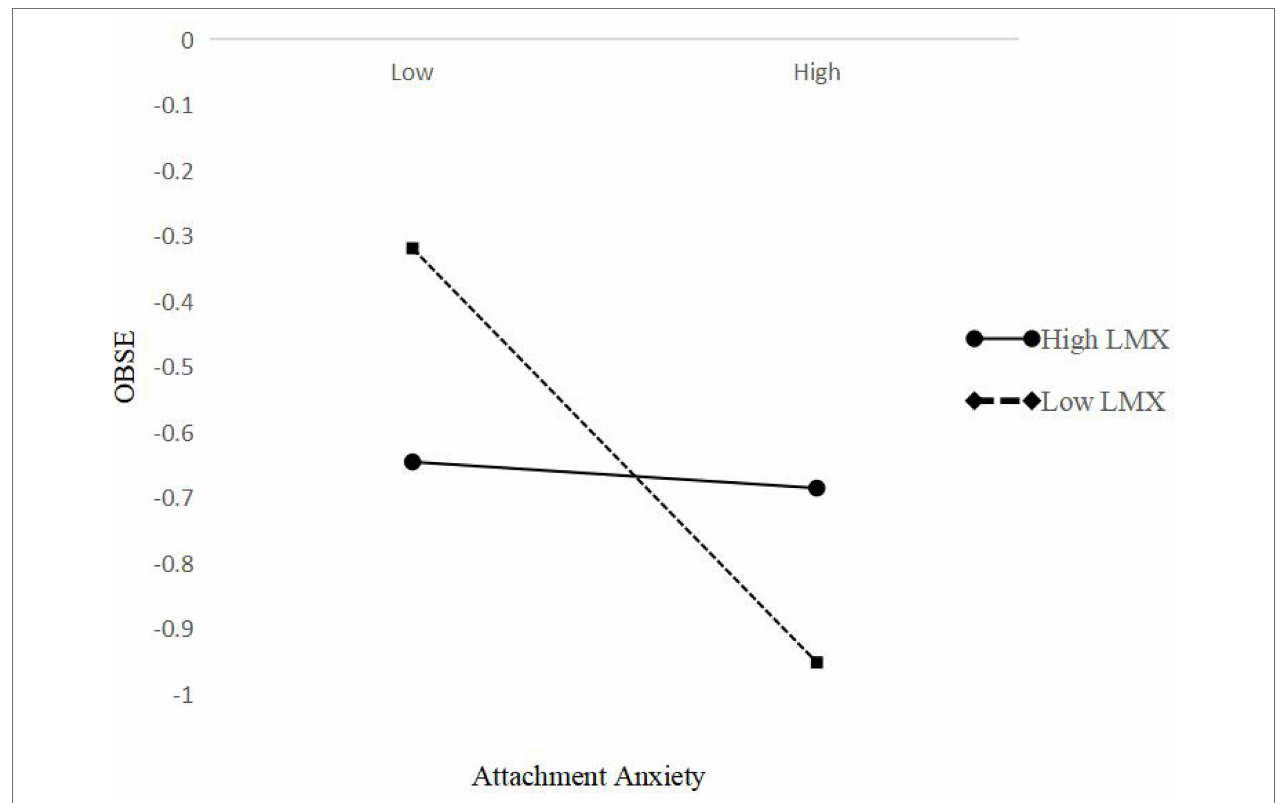
FIGURE 3 | Interactive effects of attachment anxiety and leader–member exchange (LMX) on organization-based self-esteem